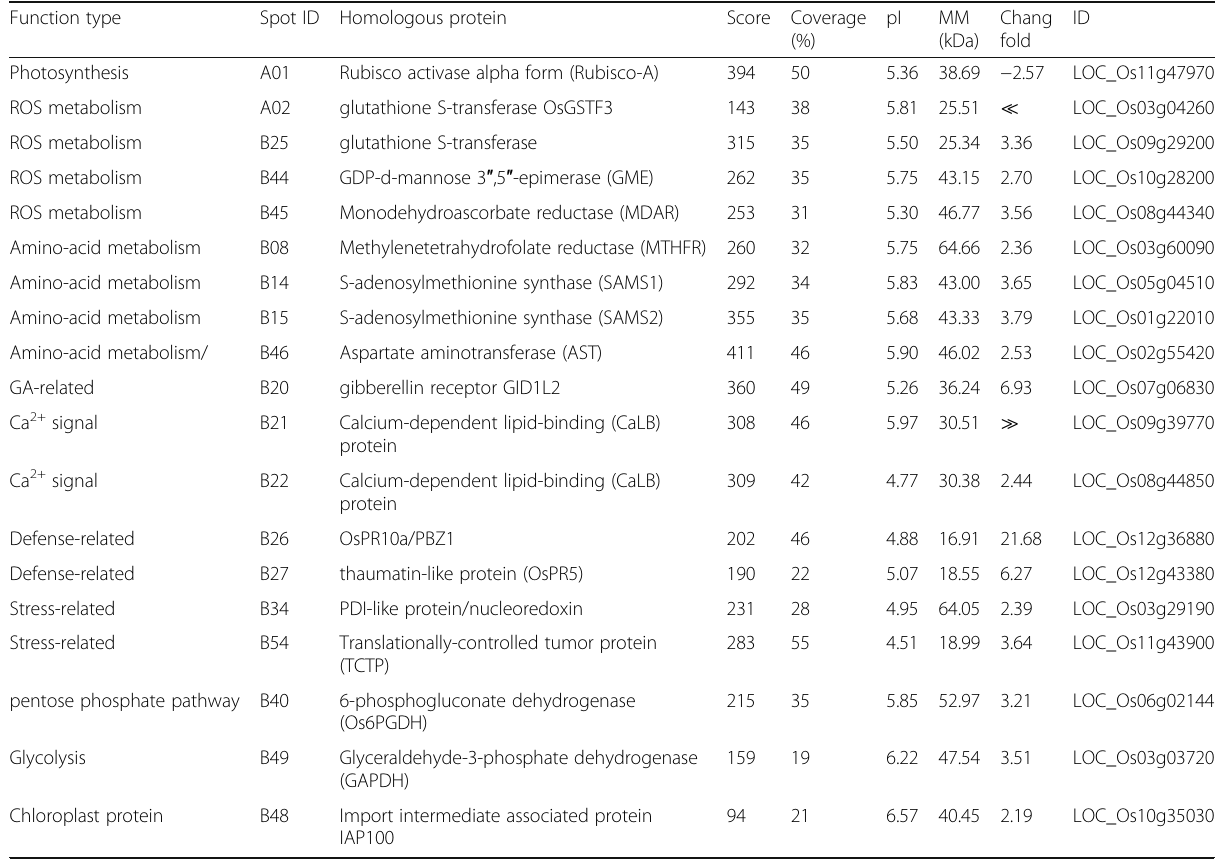
Table 1 Identification of proteins differentially expressed between WT and psl mutant Function